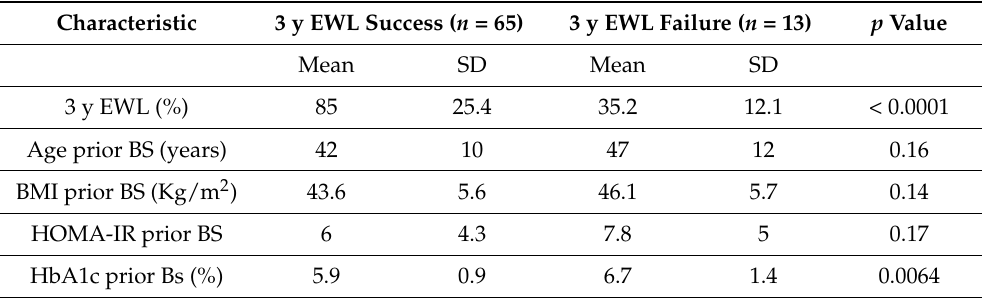
Table 4. Characteristics of patients with (or without) insufficient excess weight loss at 3 years